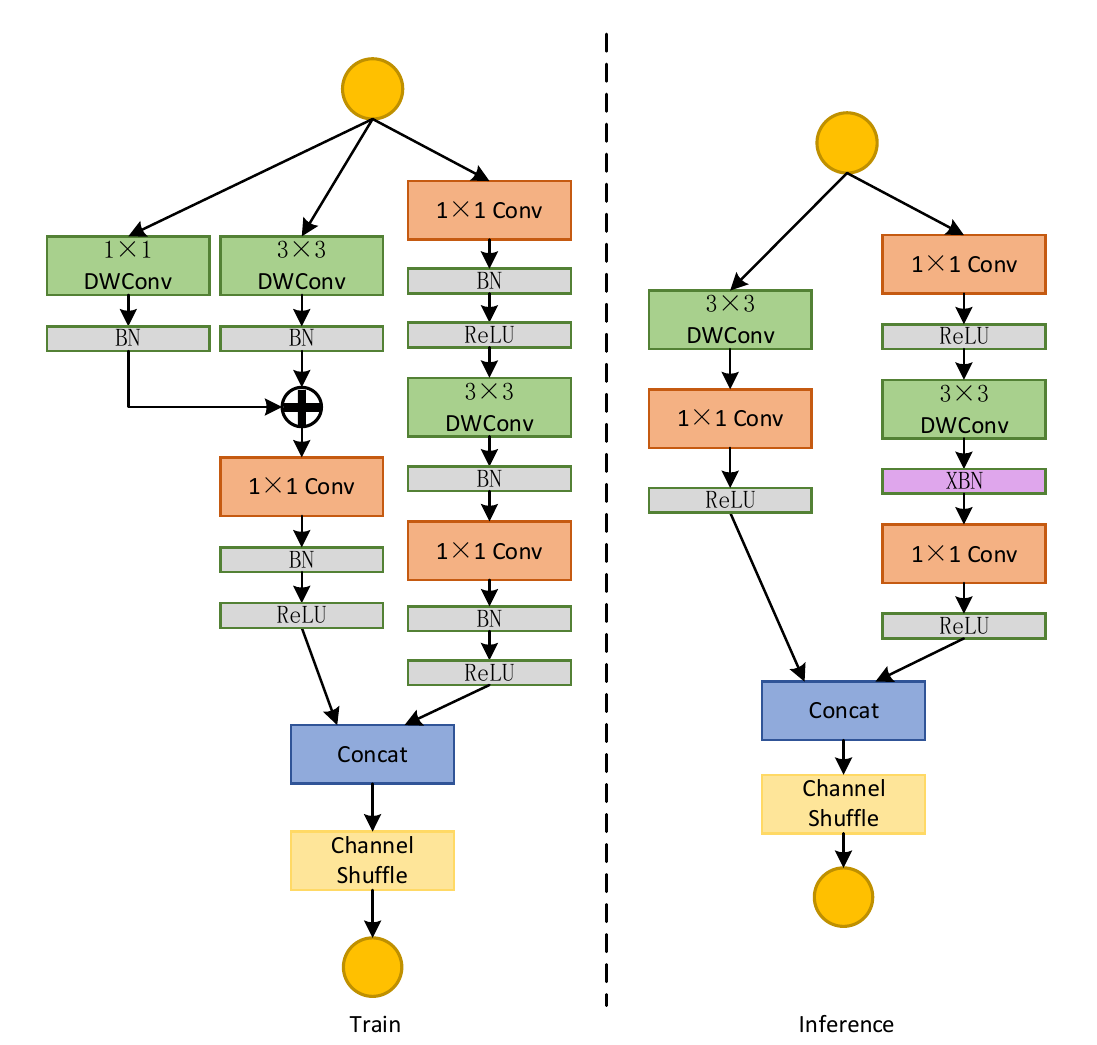
Figure 2. Training and inference module.